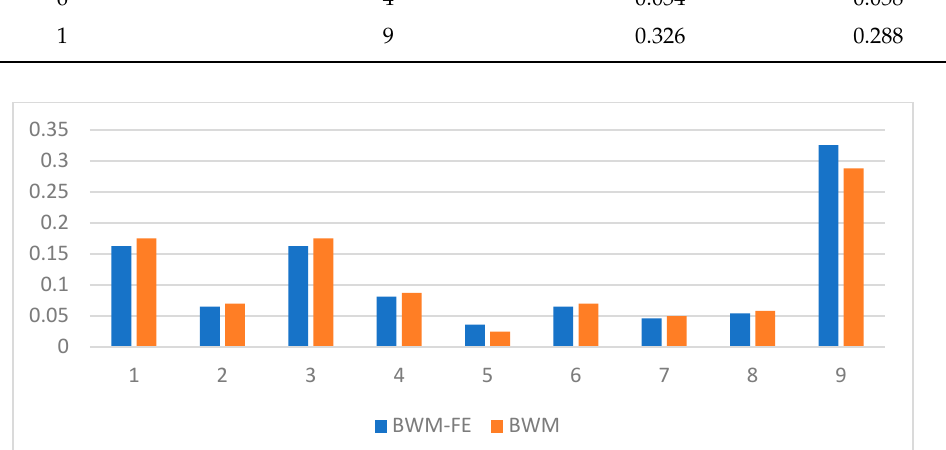
Figure 5. Vendors’ criteria weights comparison.